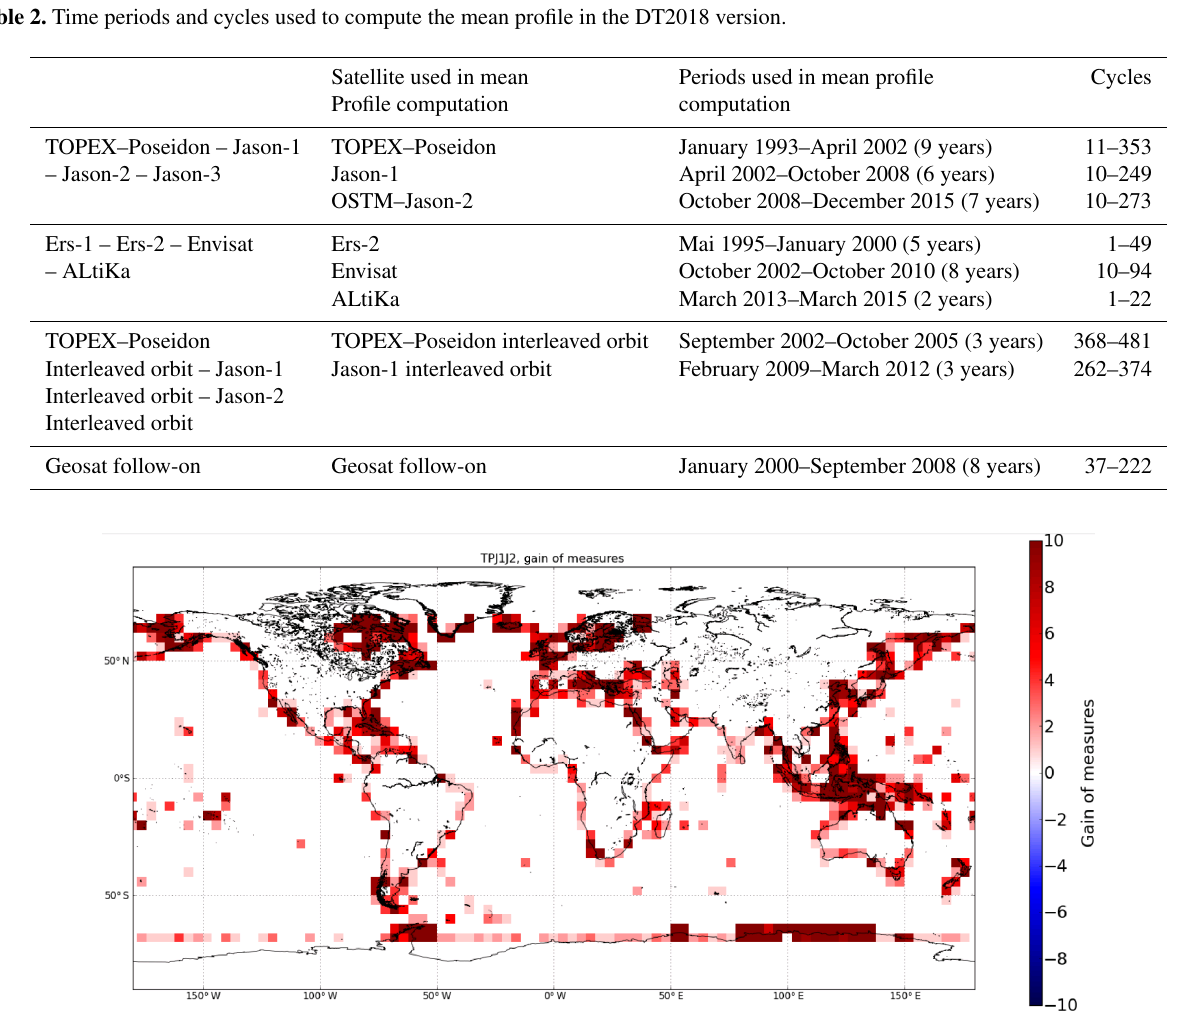
Figure 2. Gain of measurements in the TOPEX–Poseidon–Jason1–OSTM–Jason-2 mean profile used in DT2018 compared to DT2014. Gain of points in DT2018 is in red, loss of points is in